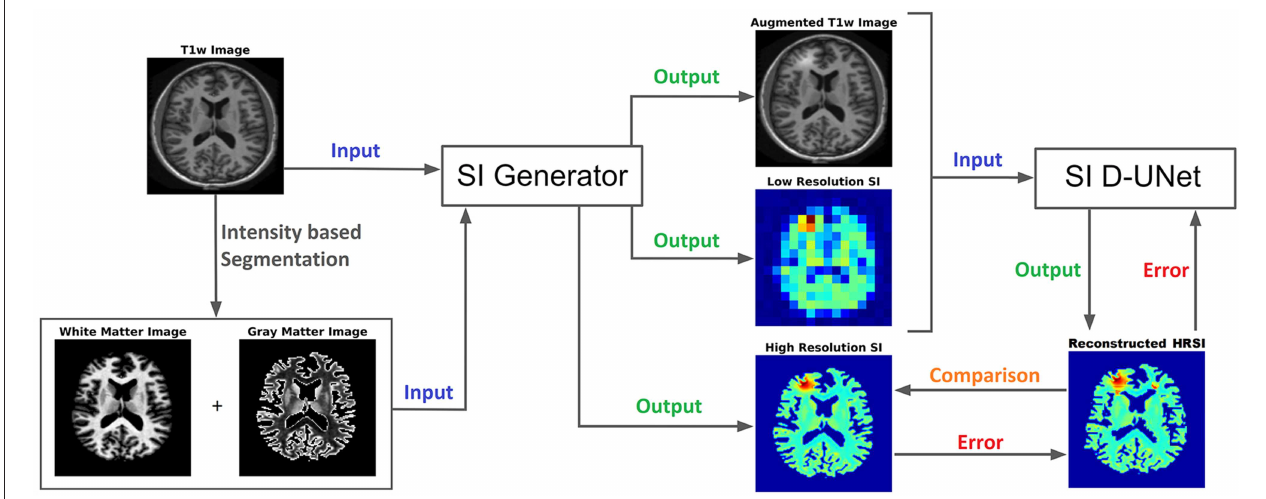
FIGURE 1 | The workflow for training the D-UNet model is shown. The SI generator provides a dataset consisting of an augmented T1w image, a low resolution spectroscopic image, and a ground truth high resolution spectroscopic image. The spectroscopic images already show the distribution of a particular metabolite (or the distribution of a particular spectral point), such as choline, and therefore do not contain a spectral dimension. Then, the network transforms the aT 1 w (128x128 pixels) and LRSI (128x128 pixels after nearest-neighbor interpolation) into an initial HRSI reconstruction (128x128 pixels). In the example above, the LRSI and HRSI reconstruction have in-plane spatial resolutions of 1.4 × 1.4 cm 2 and 1.7 × 1.7 mm 2 , respectively. This reconstruction is compared to the ground truth, and the mean squared error is calculated. Utilizing this error, the model changes the weighting parameters for the features, and continues training by using a different dataset. After training on 102,000 datasets, the model weights are refined and the reconstruction errors are minimized.